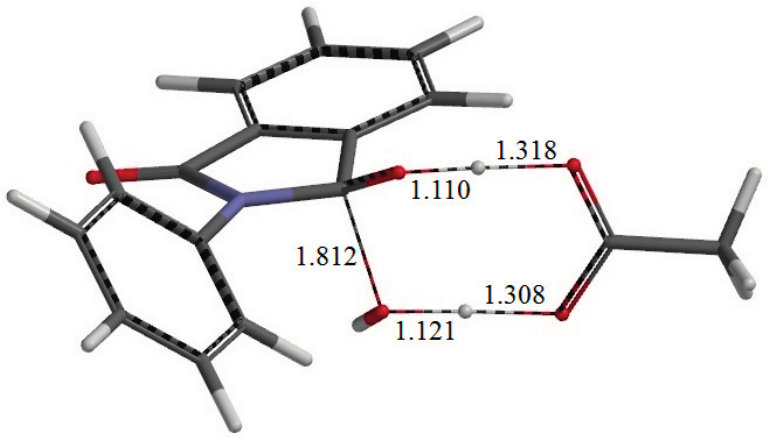
Figure 6. The geometry of IC2, the intermediate complex directly connected to TS2 (the second-step transition state shown in Figure 7). Selected interatomic distances are shown in Å. Also shown are the definitions of interatomic distances i – p .